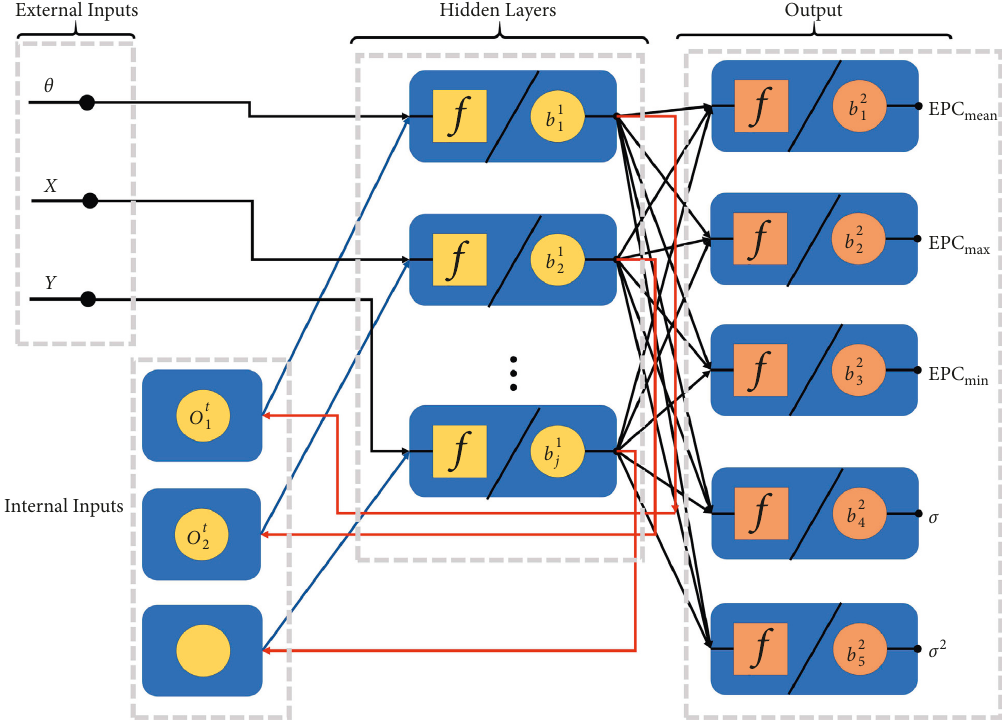
Figure 2: Recurrent neural network (RNN) architecture used. For simplicity, the synaptic weights between input layer (external and internal) and hidden layer have been